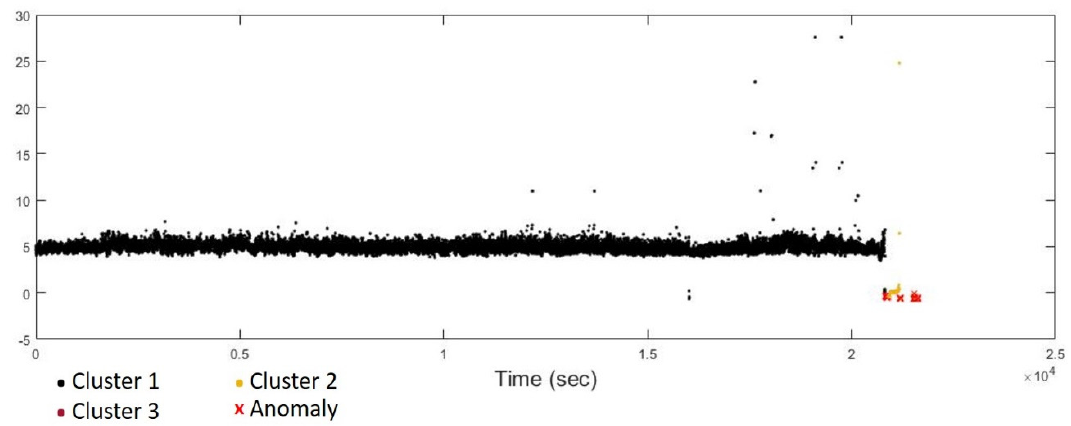
Figure 12. Novelty detection for the abrupt fault detection. Table 6. Memory savings